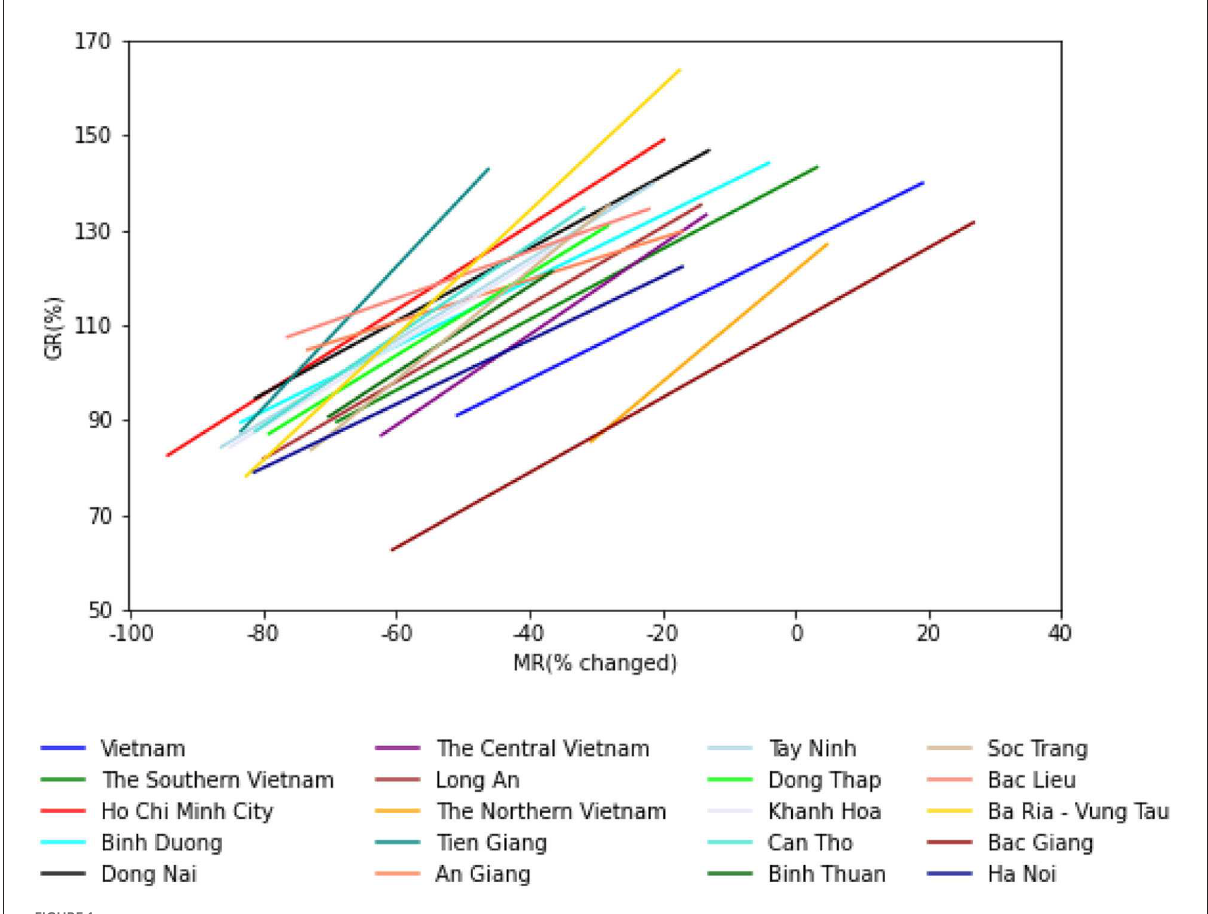
FIGURE1 GR and MR rates across the